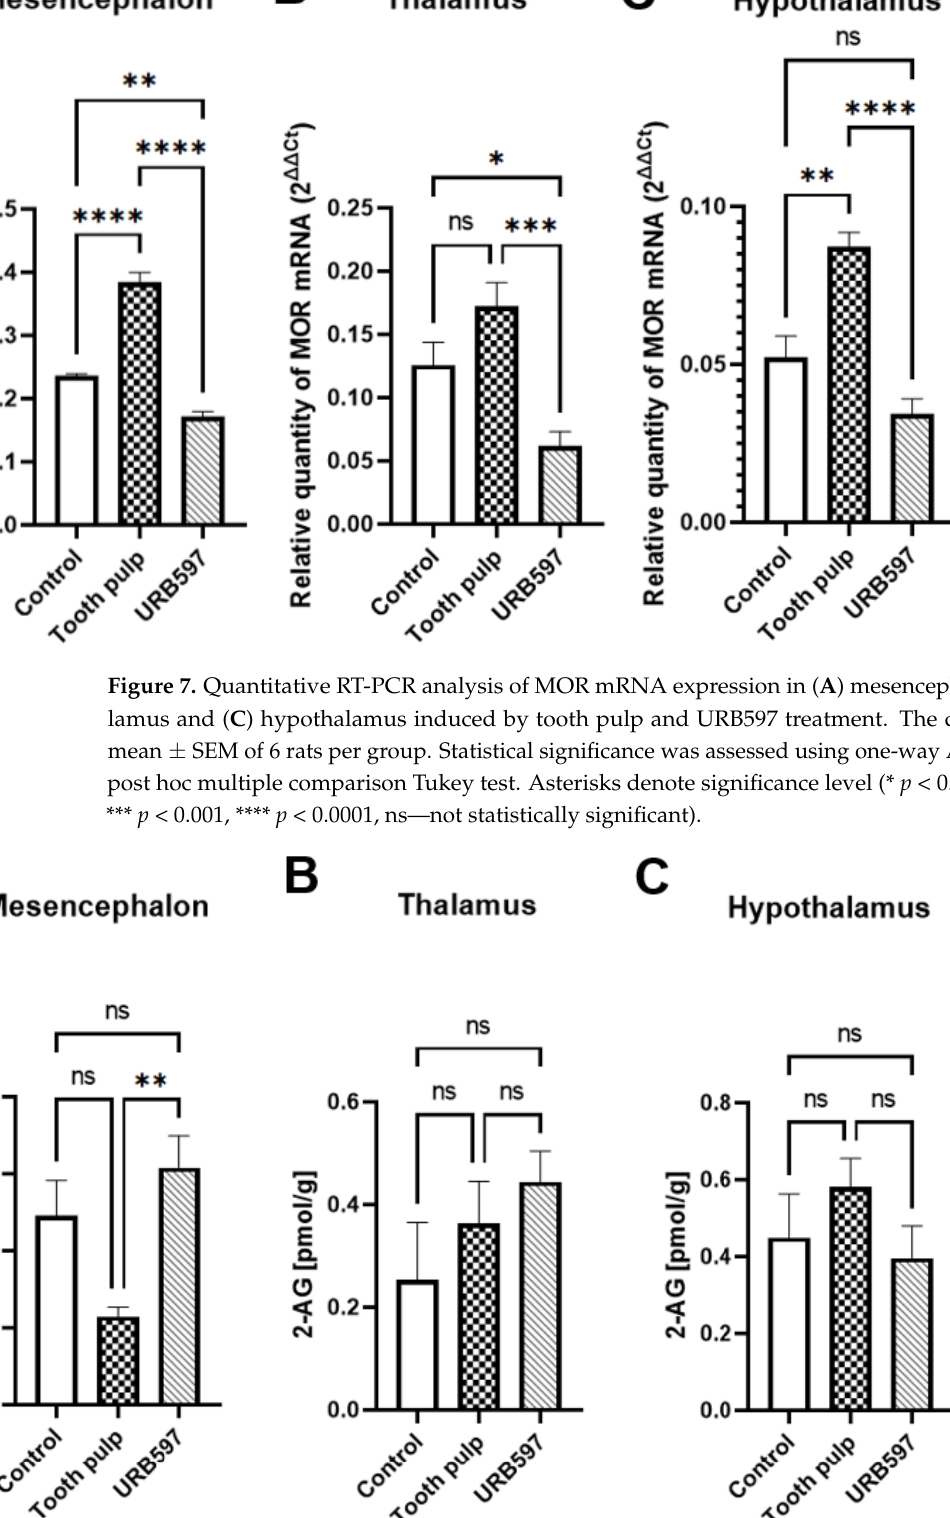
Figure 8. 2-AG concentration in rats in controls and after tooth pulp and URB597 treatment. The data represent mean ± SEM of 6 rats per group. Statistical significance was assessed using one-way ANOVA and a post hoc multiple comparison Tukey test. Asterisks denote significance level (** p < 0.01, ns — not statistically significant).